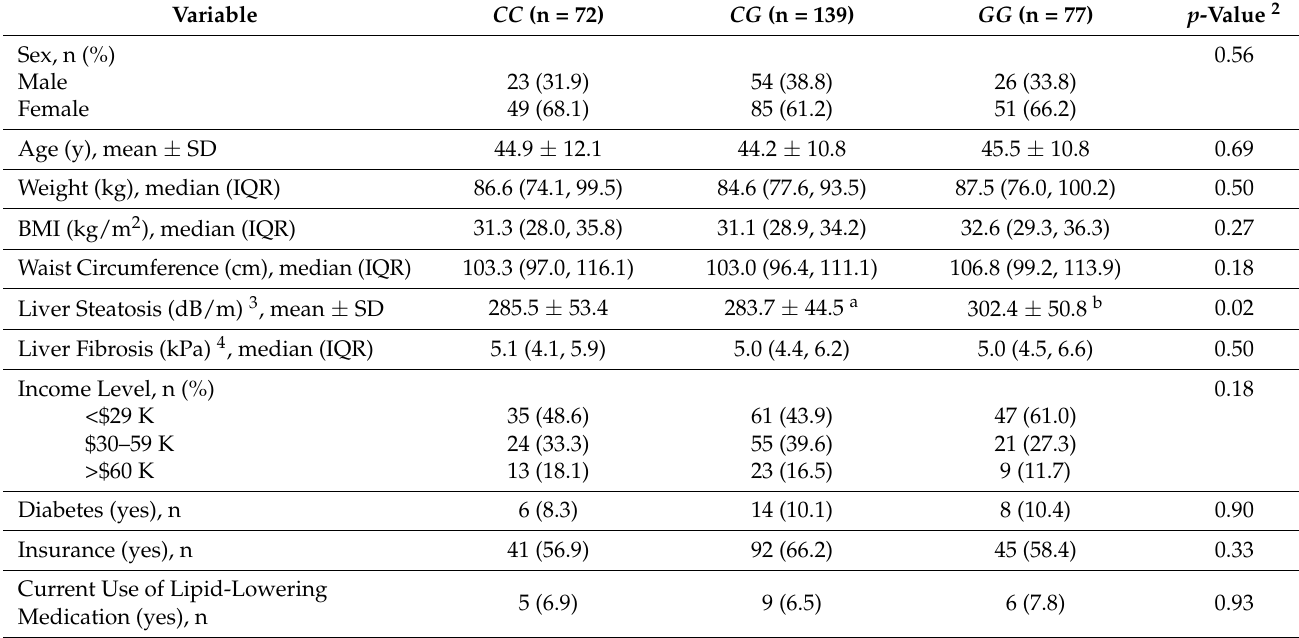
Table 1. Demographic and Clinical Characteristics of Mexican-Origin Participants by PNPLA3 Genotype (n = 288) 1